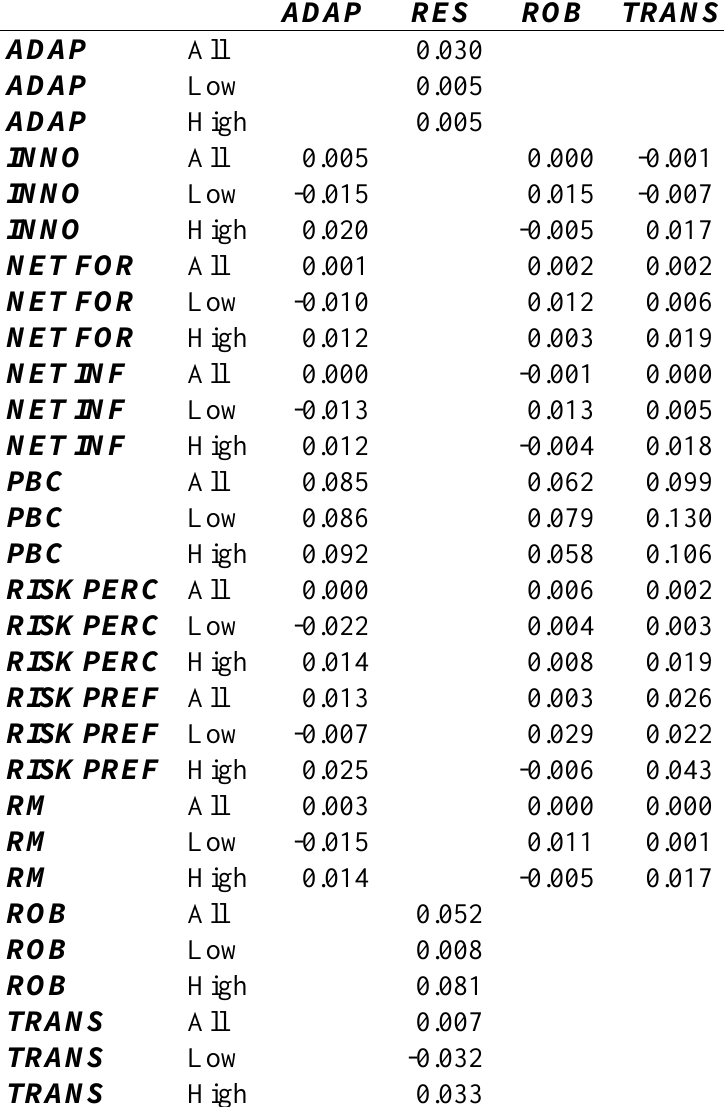
Table A1.7. q 2 statistics of the structural model